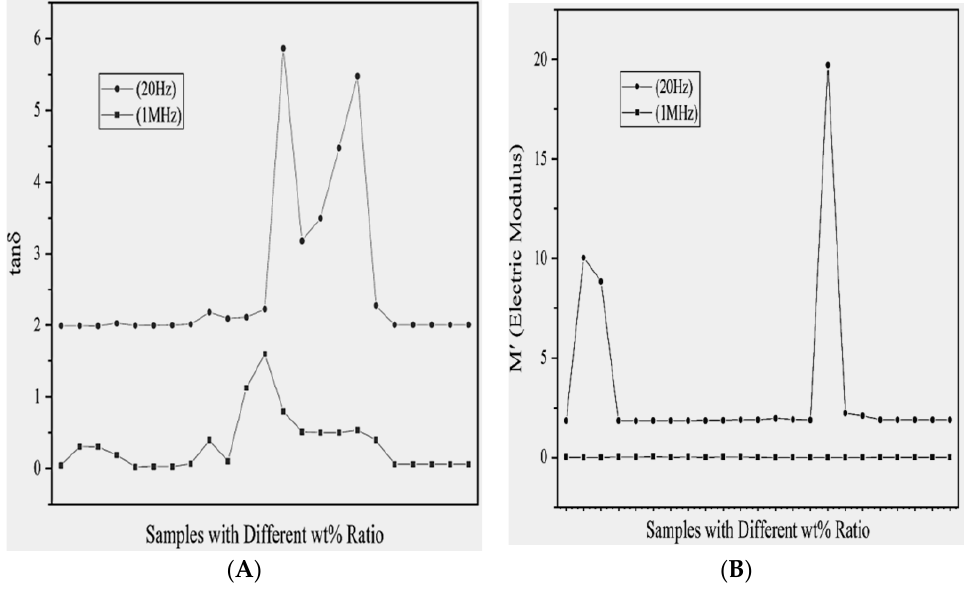
Figure-8. Variation in ( A ) dielectric loss ‘tanδ’ and ( B ) electric modulus ‘M′ of different Figure 8. Variation in ( A ) dielectric loss ‘tan δ ’ and ( B ) electric modulus ‘M’ of different polymer polymer composite samples at low (20 Hz) and high (1 MHz) frequencies. composite samples at low (20 Hz) and high (1 MHz)